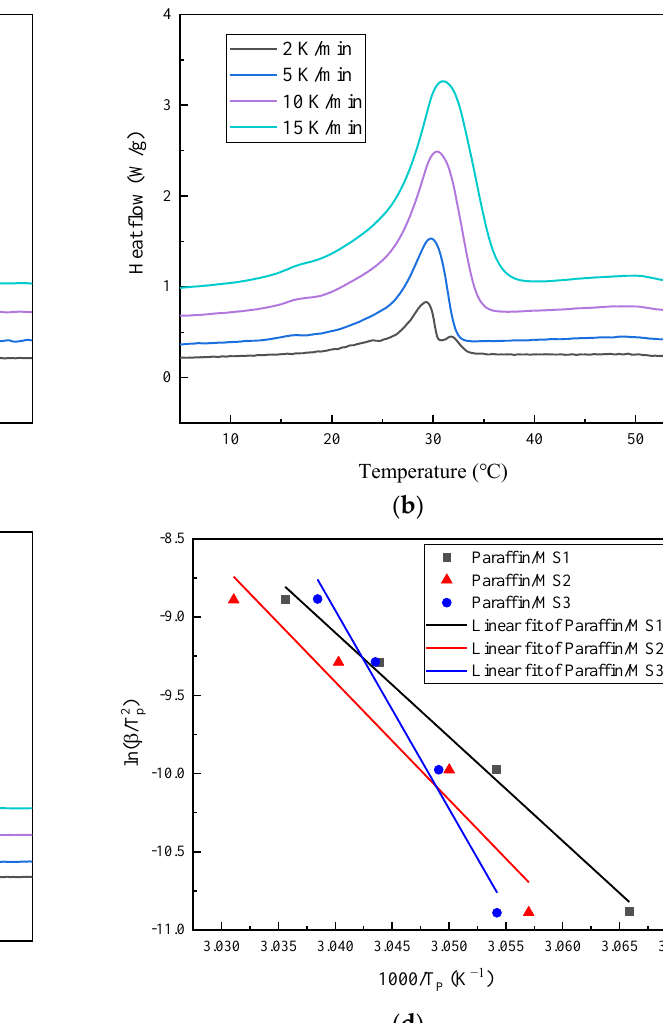
Table 3. Activation energy calculations of paraffin/MS SS-PCMs with different pore diameters of MS. SS-PCMs